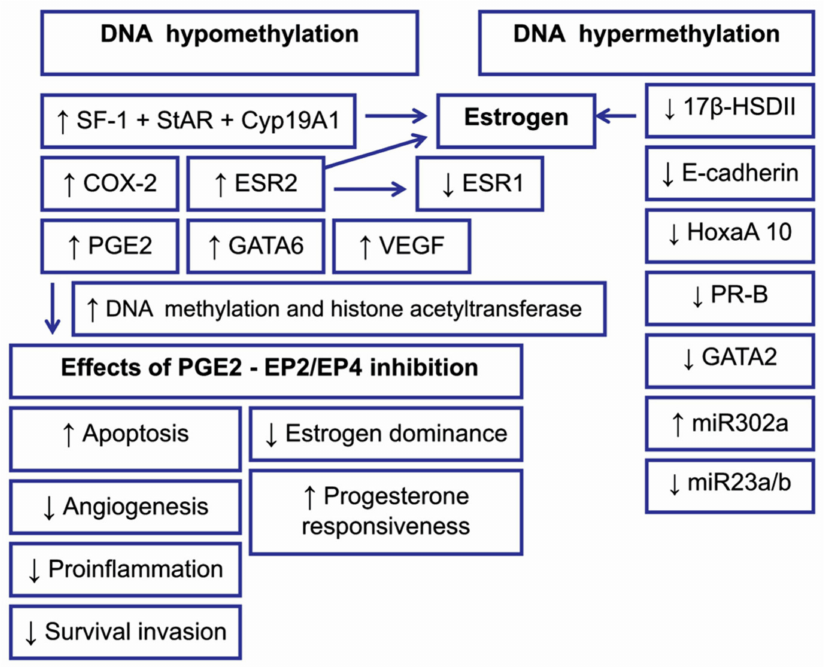
Figure 3. DNA hypo- and hypermethylation in endometriosis. E ff ects of PGE2-EP2 / EP4 inhibition may be due to epigenetic mechanisms such as DNA methylation and histone modification.